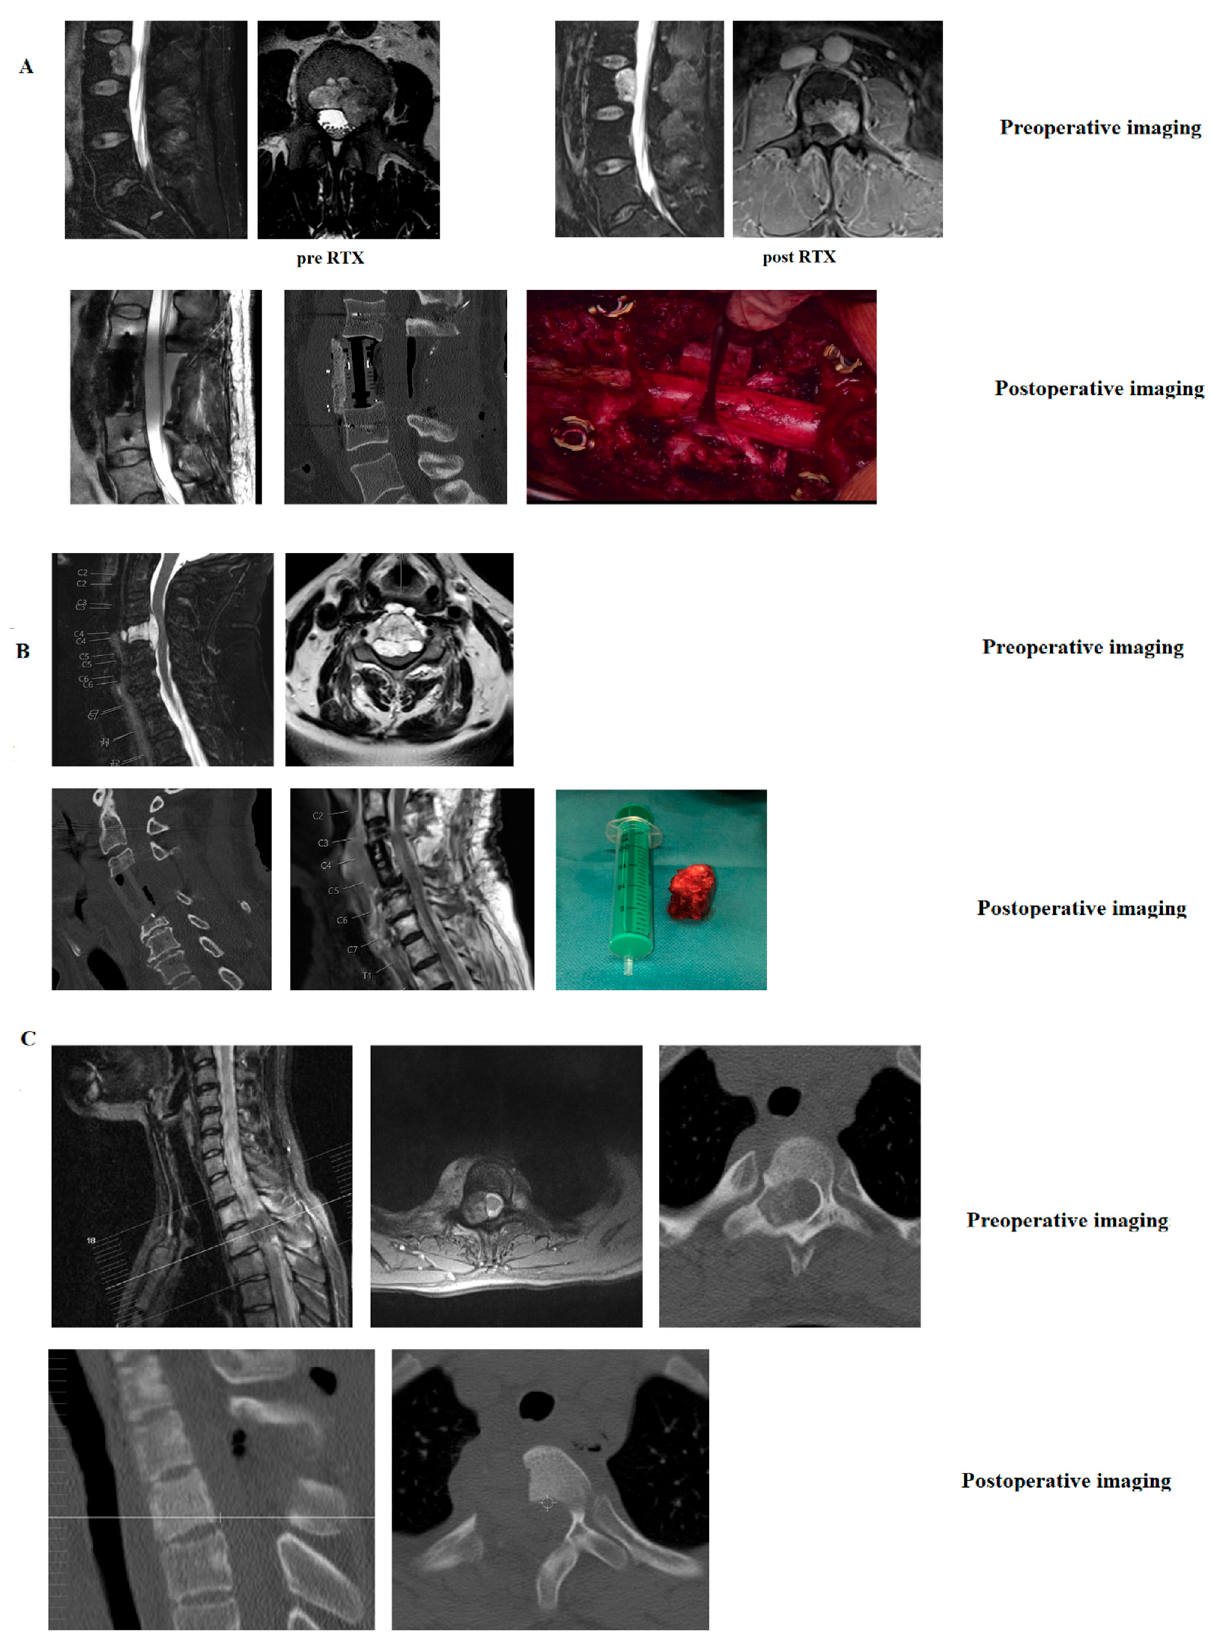
Figure 5. ( A – C ) Case